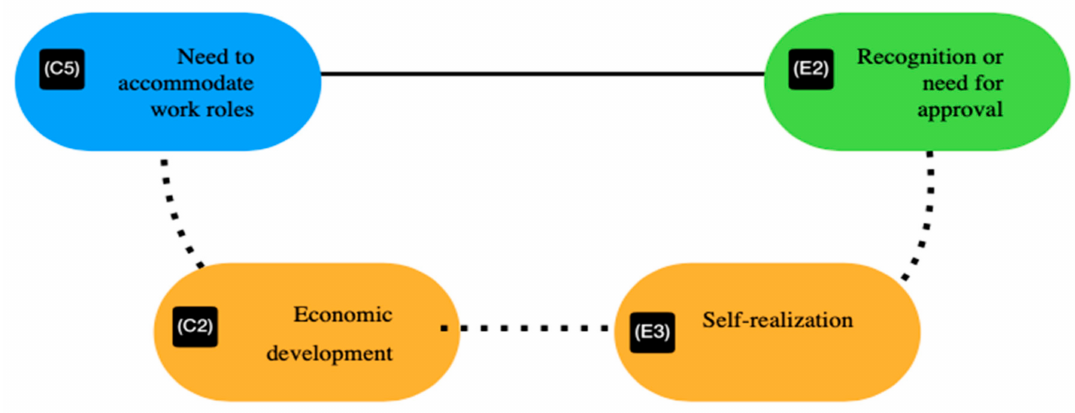
Figure 6. Contributing to society and needing to be challenged. Incident C 5 → E 2 . Source: Authors’ elaboration based on fuzzy